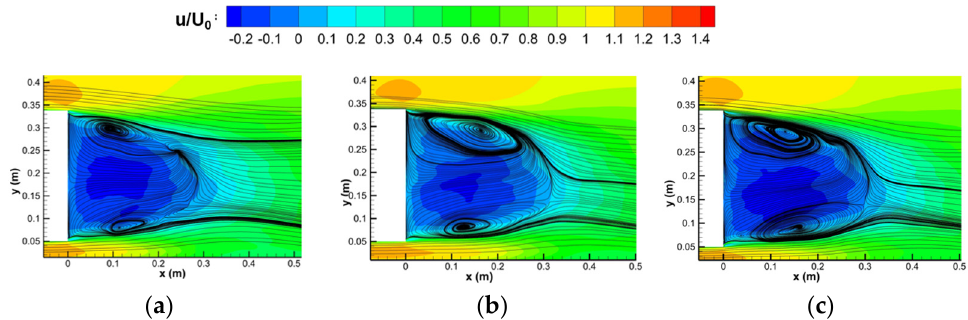
Figure 12. Time-averaged streamlines behind of model, on the symmetry plane with different actuator types. ( a ) A steady blowing jet; ( b ) a synthetic jet; ( c ) an unsteady jet.